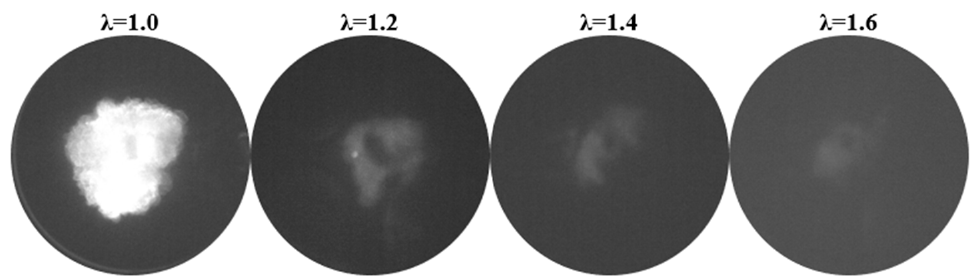
Figure 1. Decrease in brightness as the air/fuel ratio increases.